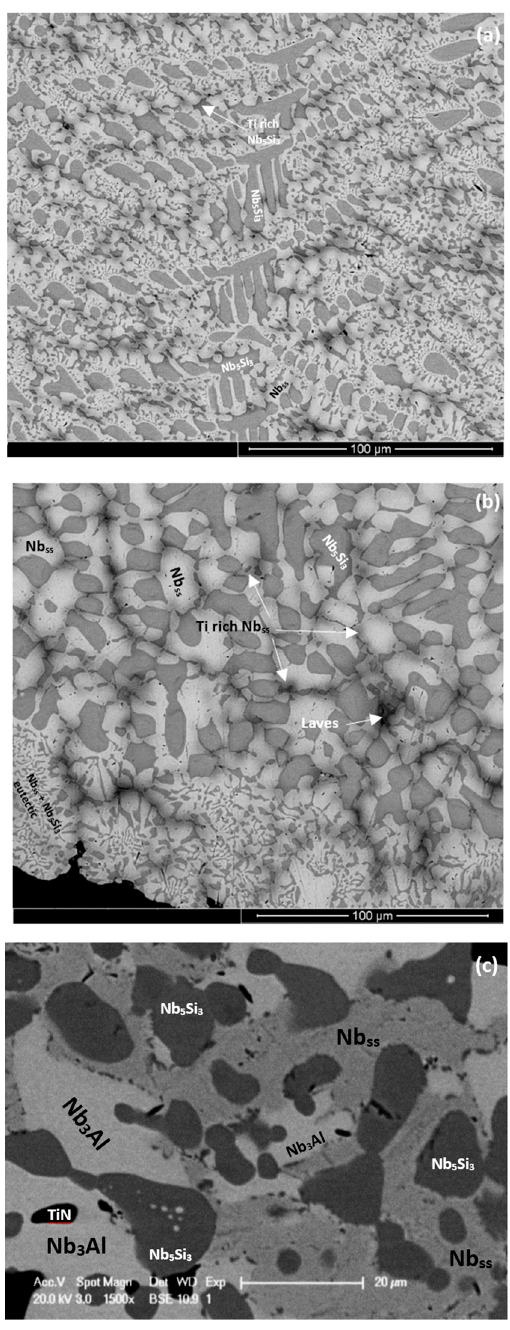
Figure 3. BSE images of the microstructure ( a ) of the bulk and ( b ) bottom of the cast and ( c ) heat-treated alloy ZX7.